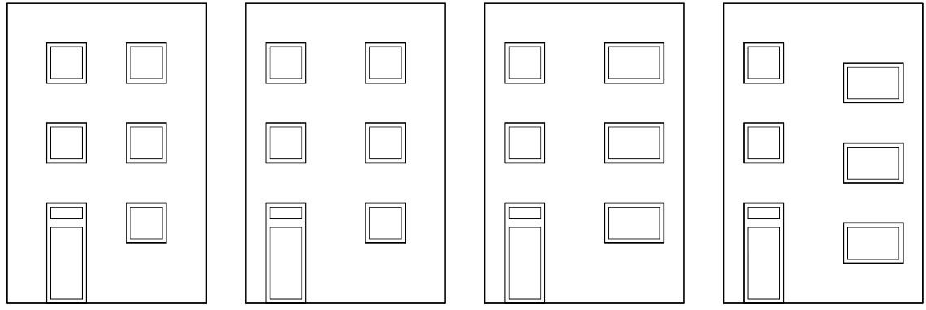
Figure 9. Test-Cases (from left to right: TestFile-A, TestFile-B, TestFile-C and TestFile-D.